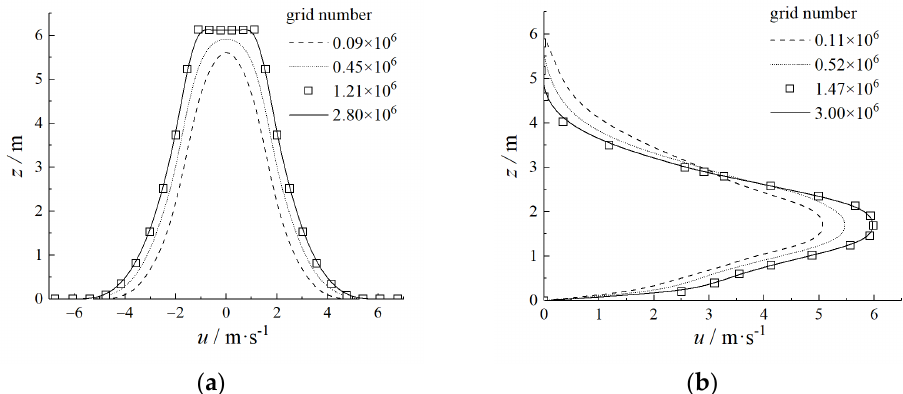
Figure 3. Velocity profile of pollutant dispersion with different mesh numbers: ( a ) vertical discharge pattern; ( b ) horizontal discharge pattern.